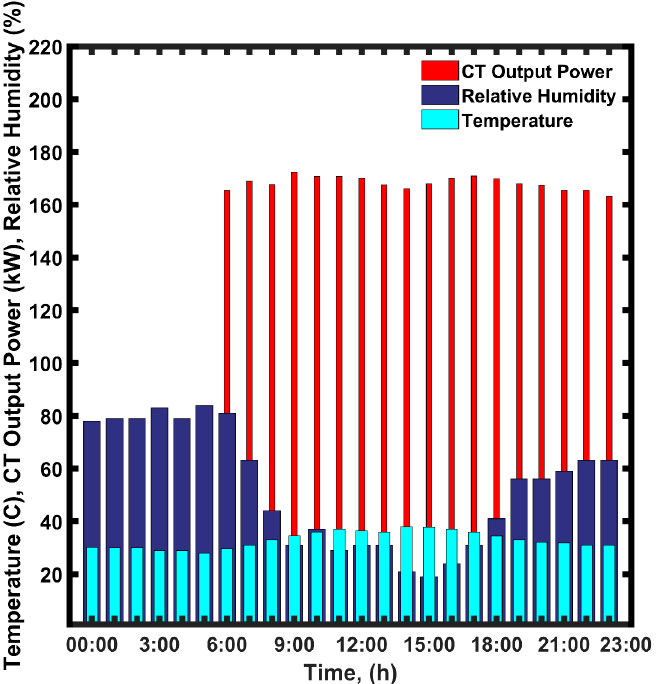
Figure 3. A 24 h profile of electrical power production for the CT, ambient temperature, and humidity on 21 June.